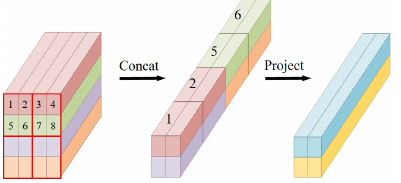
Figure 6. To describe this operation more visually, we use different colors for the features of different rows. The original tokens in the red box are concatenated with their feature vectors in the spatial dimension(e.g. 1, 2, 5 and 6 tokens), then projected to the specified feature